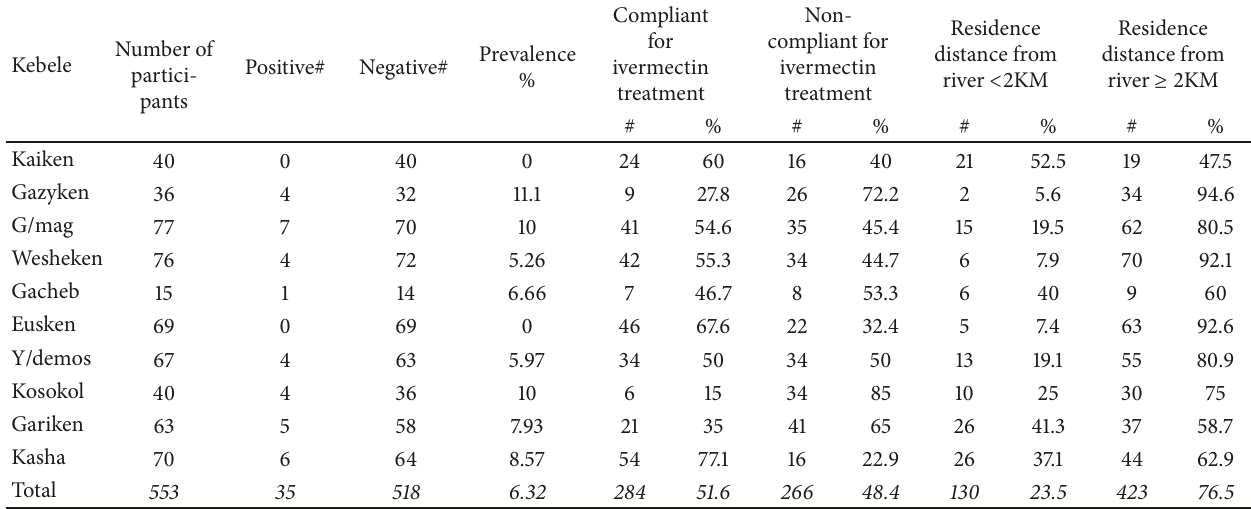
Table 2: Prevalence of onchocerciasis, Semen Bench district, Bench Maji Zone, June 2018 (n=553).